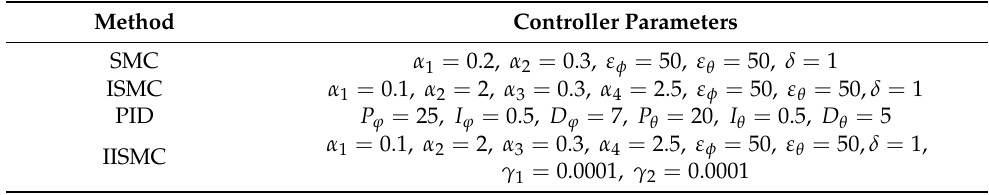
Table 3. Controller parameters for attitude-control algorithms.